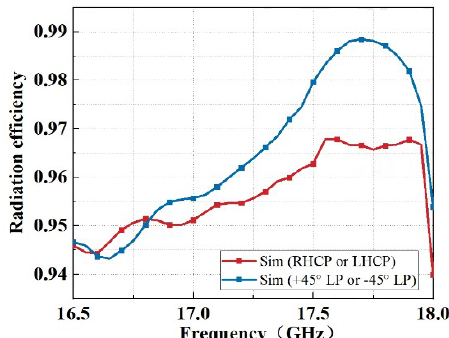
Figure 13. The radiation efficiency of the designed antenna.